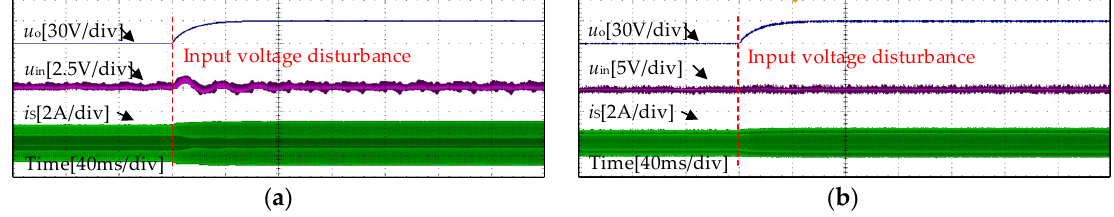
Figure 14. Starting process experimental waveforms: ( a ) with the traditional constant compensation control method; ( b ) with the proposed VDCC method.